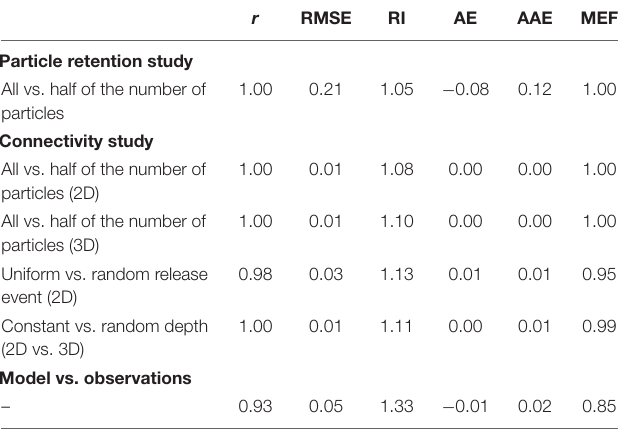
TABLE 1 | Summary statistics, including the correlation coefficient ( r ), root mean square error (RMSE), reliability index (RI), average error (AE), average absolute error (AAE), and the modeling efficiency (MEF), of the sensitivity tests performed throughout the study. RMSE RI AE AAE MEF